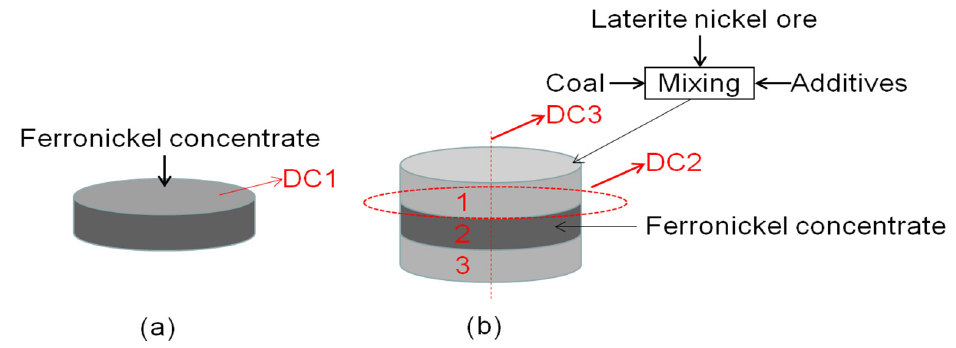
Figure 13. Schematic diagram of diffusion experiment sample (R = 1 cm); ( a ) Schematic diagram of ferronickel concentrate layer, ( b ) Schematic diagram of experimental sample.